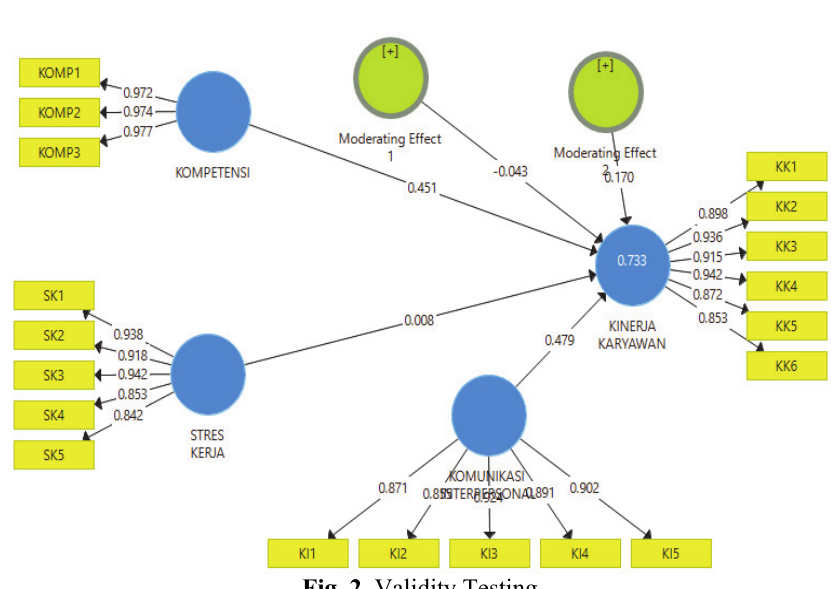
Reliability Test